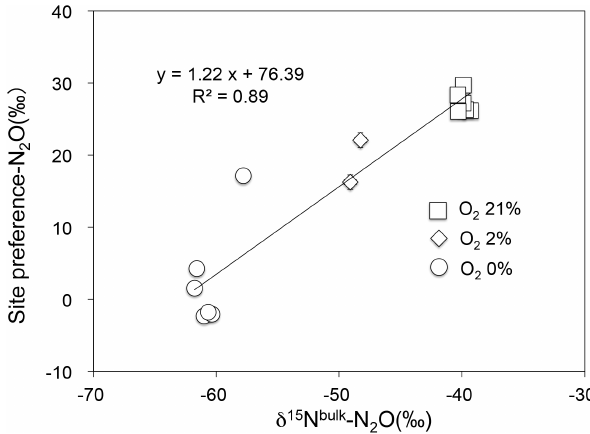
Figure 3. Site preference and δ 15 N of N 2 O in concentrated cell suspensions of N. oceani under different initial O 2 concentrations. Error bar indicates the measurement